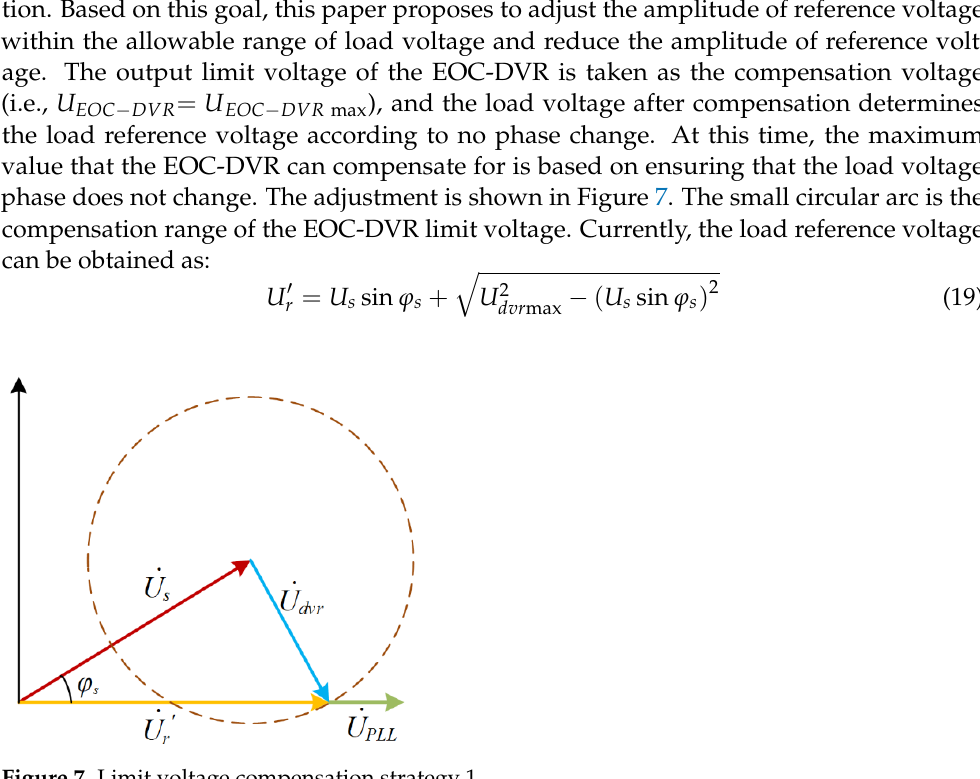
Figure 7. Limit voltage compensation strategy